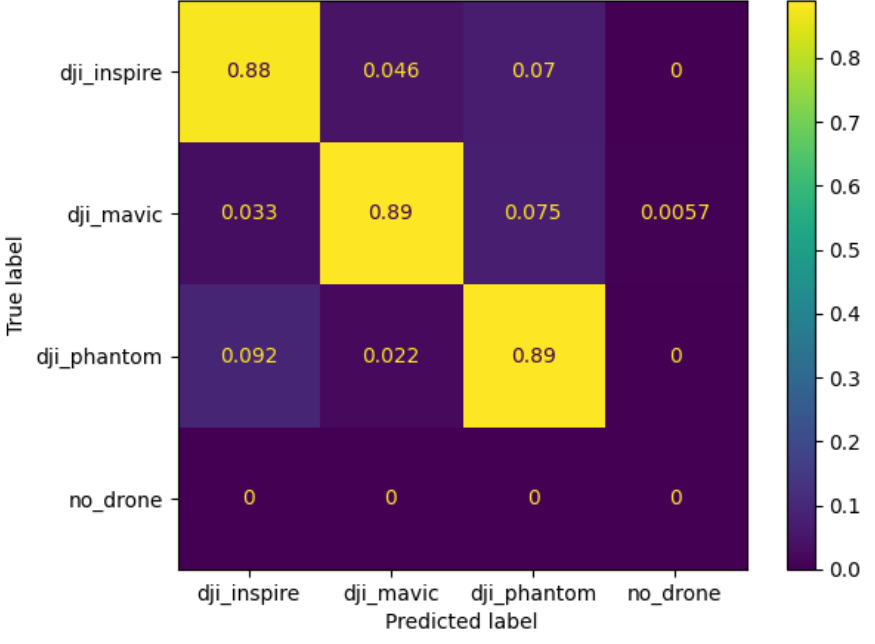
Figure 10. Confusion Matrix of the best performing